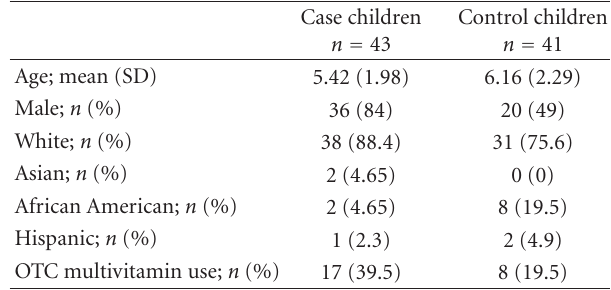
Table 1: Demographics of study